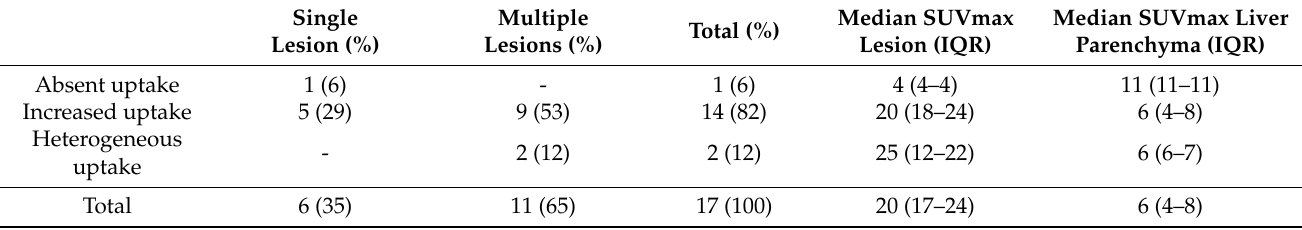
Table 2. PSMA-PET liver findings at qualitative analysis including both true positive and false positive lesions ( n =